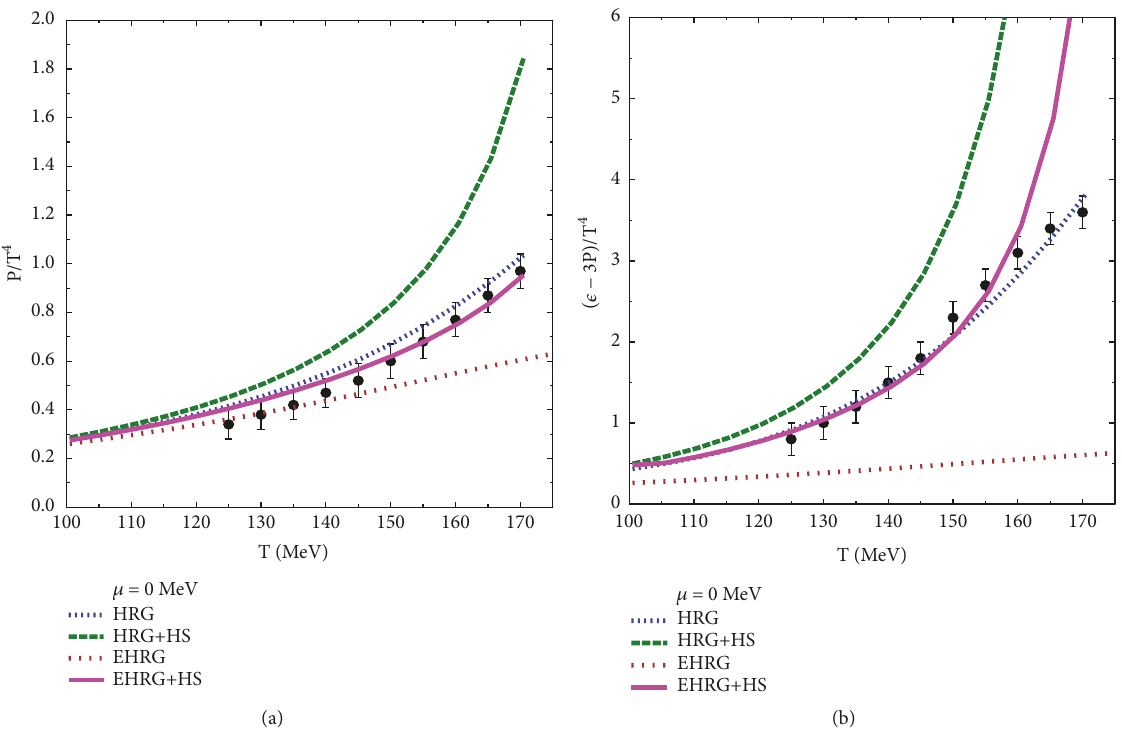
Figure 1: Thermodynamical functions, pressure (a) and trace anomaly (b), at zero chemical potential. The hard-core radius of all the hadrons has been set to the value 𝑟 ℎ = 0.4 fm. The Hagedorn mass spectrum is given by (4). The LQCD data has been taken from